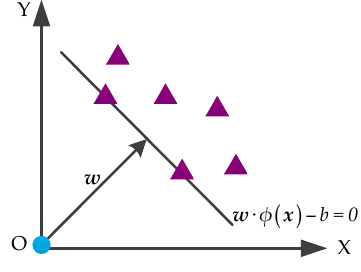
Figure 7. The classification principle of OCSVM.